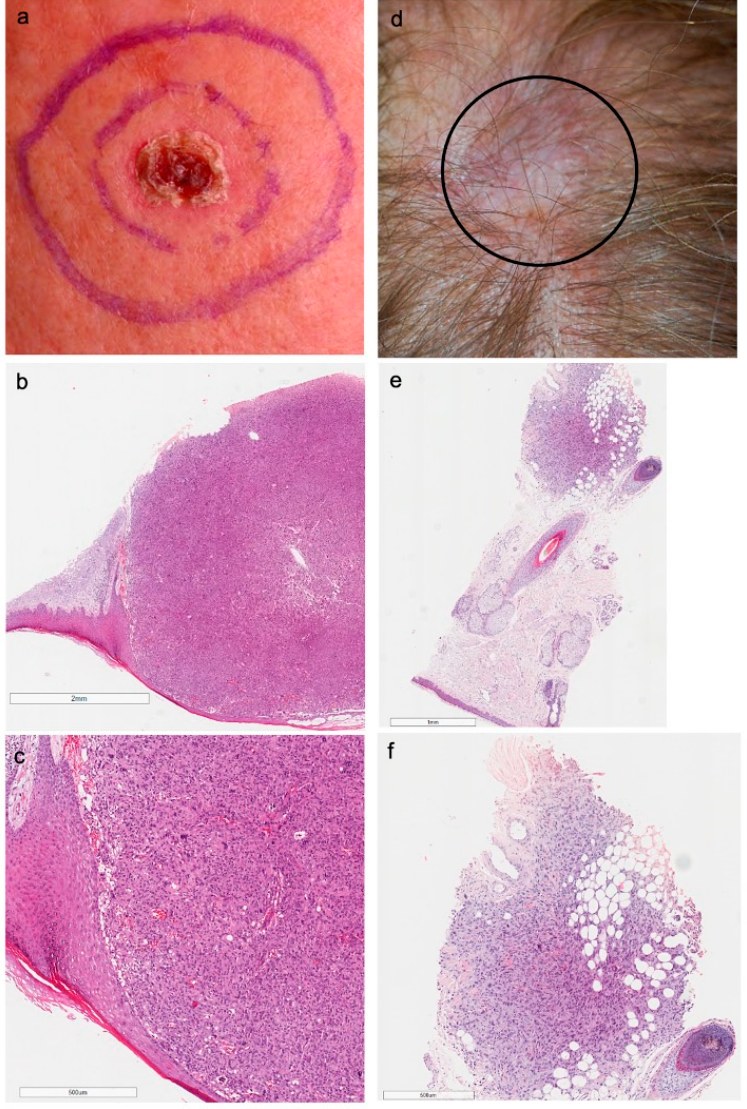
Figure 2. Clinical and histological picture of a male patient with AFX ( a – c ) and a female patient diagnosed with PDS ( d – f ). ( a ) AFX located at the vertex, ( b ) proliferation of pleomorphic spindle cells located under a thinned and ulcerated epidermis, ( c ) high power representation of atypical mitotic figures and multinucleated giant cells, ( d ) PDS located at the vertex, ( e ) neoplastic cells located at the deep dermis and infiltrating subcutaneous tissue, ( f ) pleomorphic, spindle-shaped neoplastic cells.